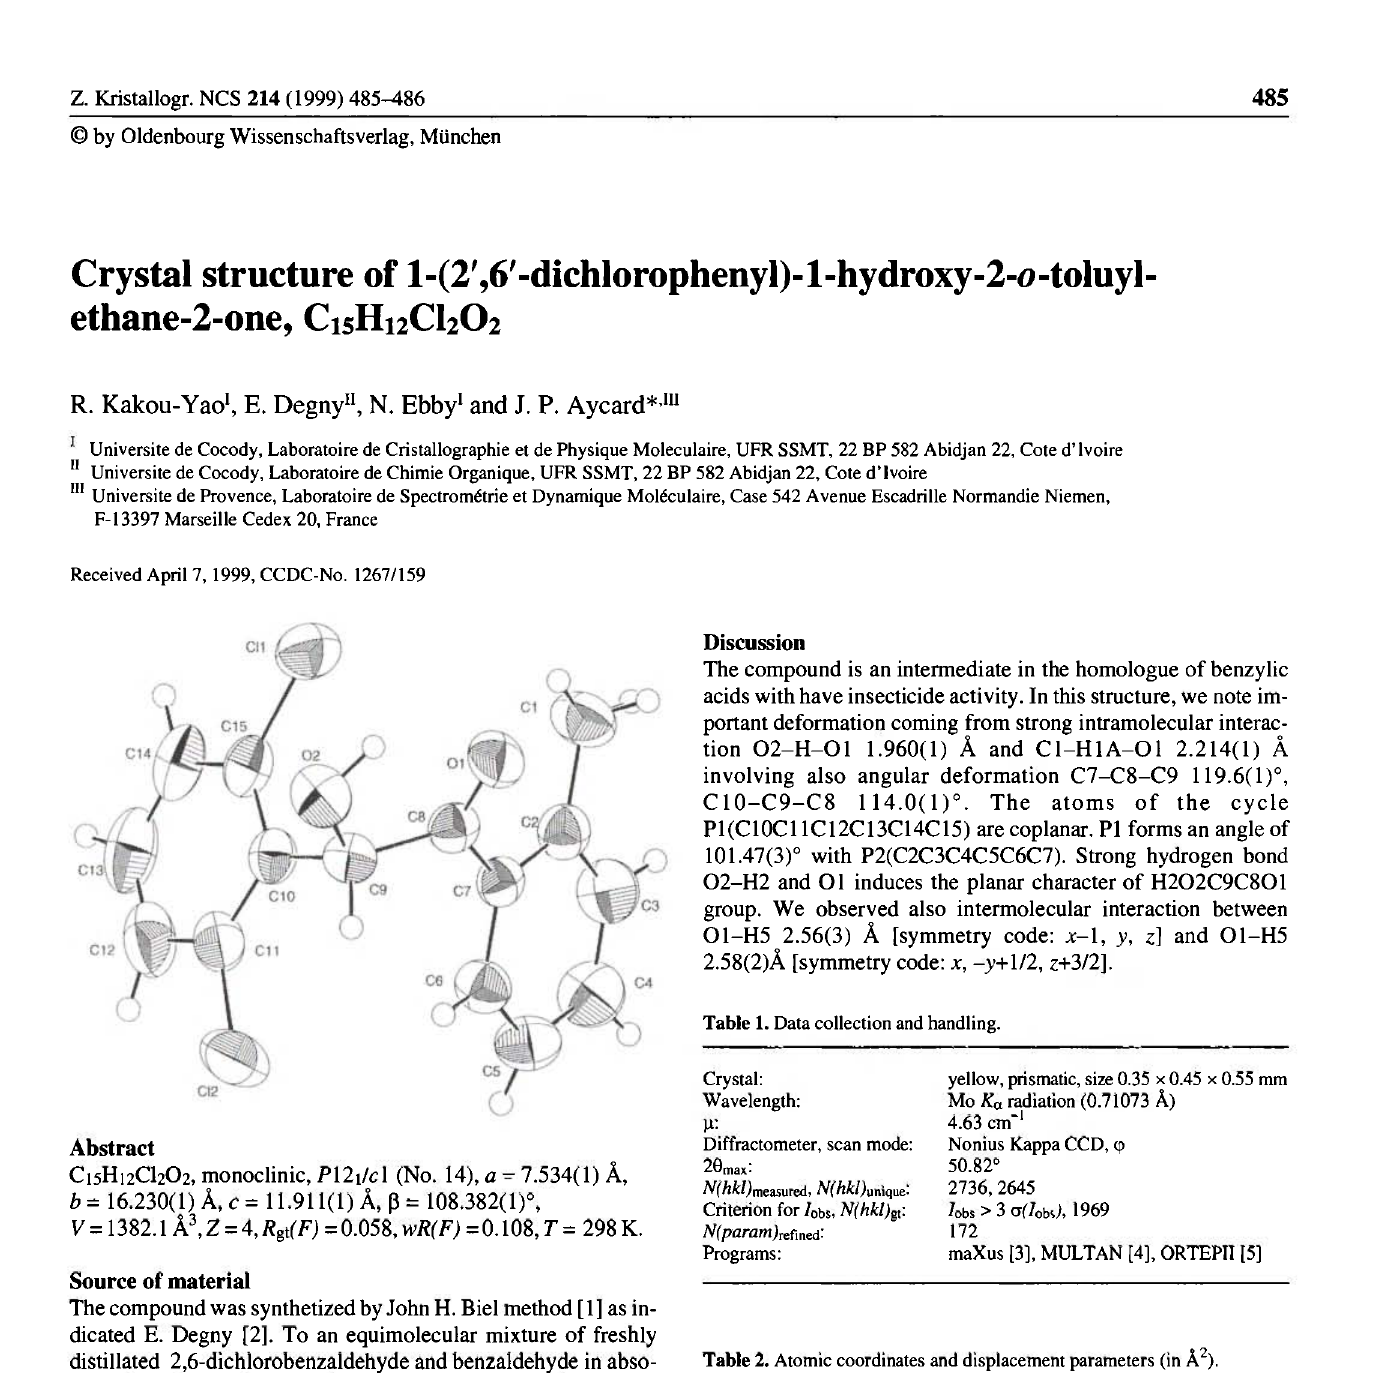
Table 2. Atomic coordinates and displacement parameters (in Ä 2